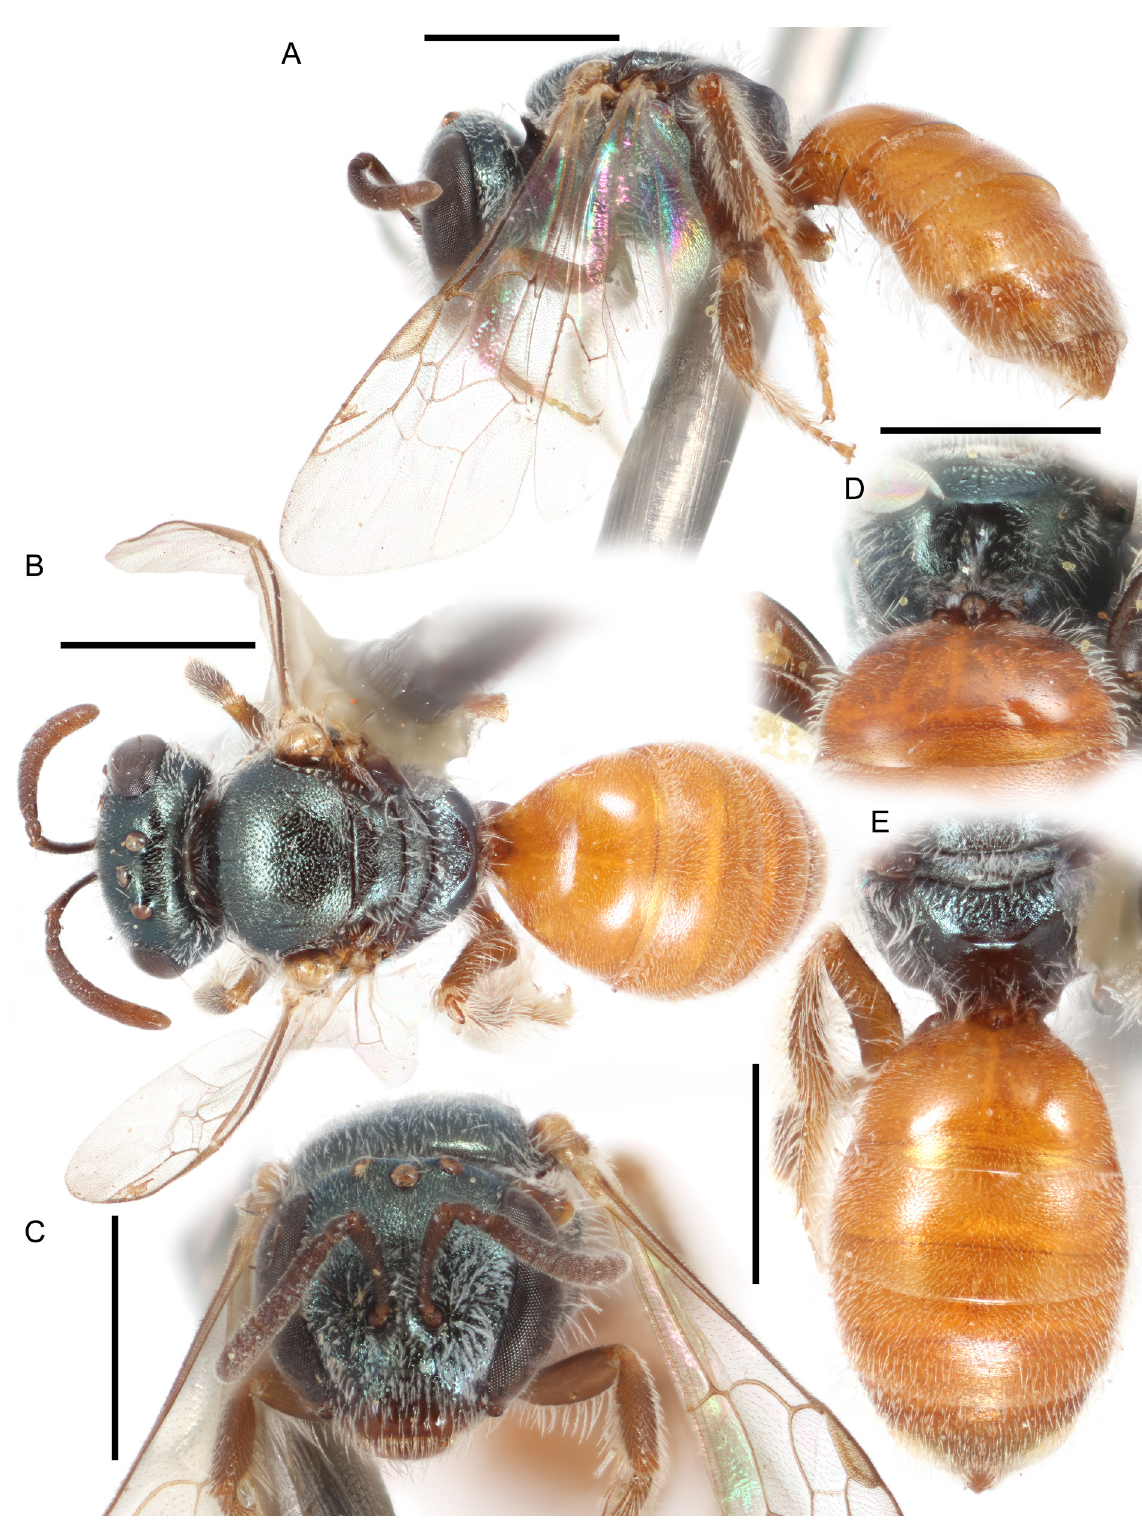
Fig. 64. Lasioglossum ( D. ) minckleyi sp. nov., ♀. A . Lateral habitus. B . Dorsal habitus. C . Face. D . Propodeum. E . Metasoma. Scale bars: 1